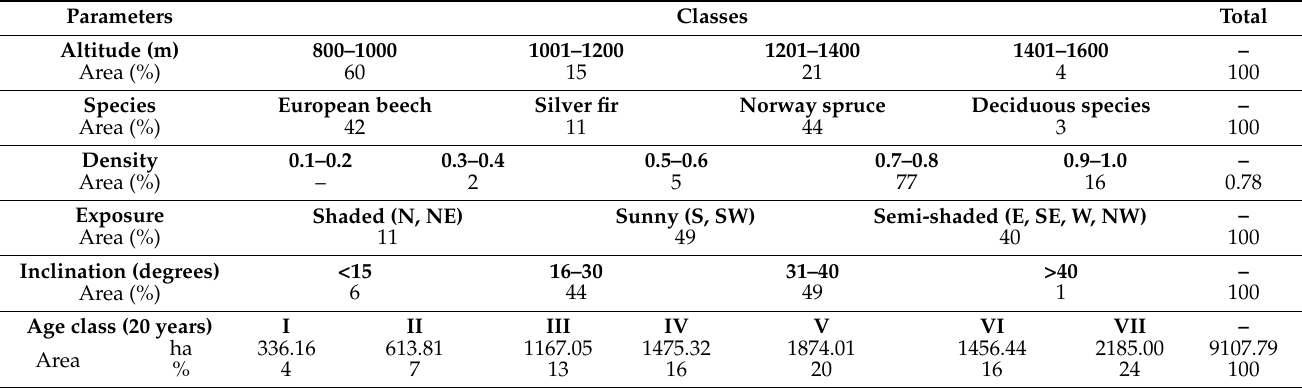
Table 2. General characterization of the studied area.